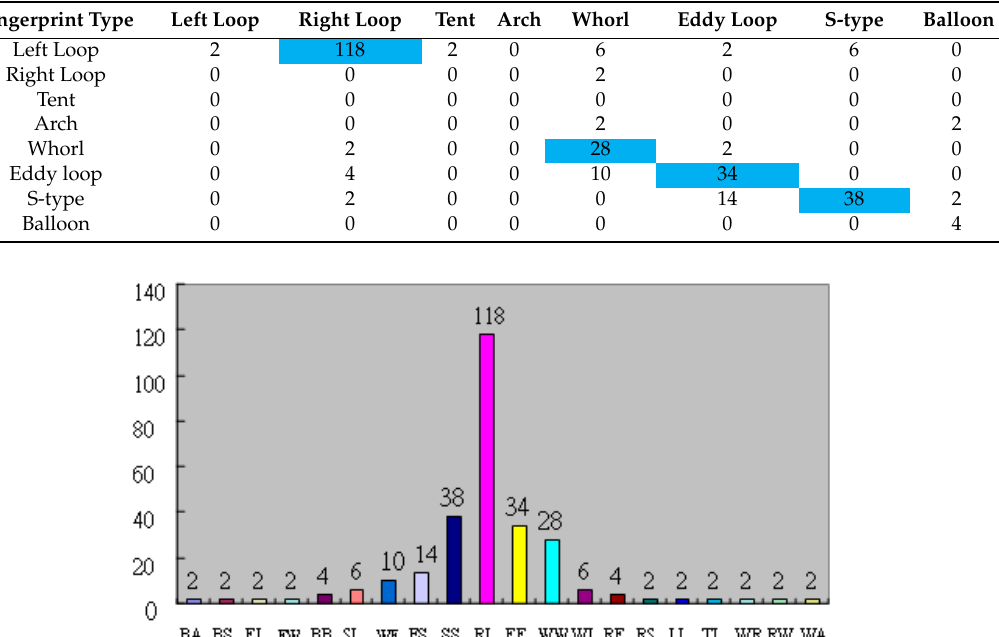
Table 2. Fingerprint type number summary.